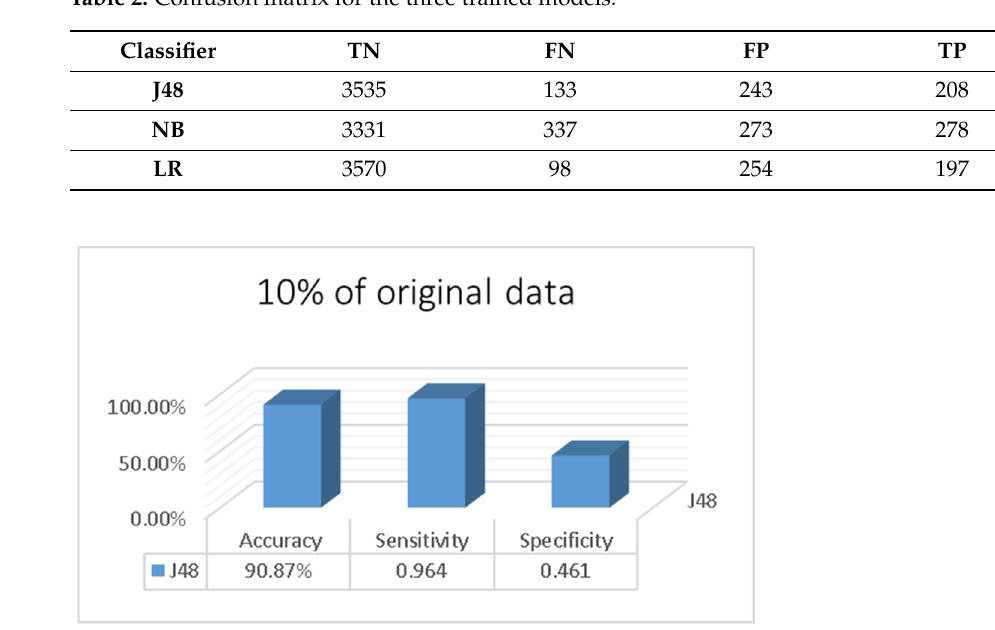
Figure 3. Accuracy, specificity and sensitivity for J48 decision tree.